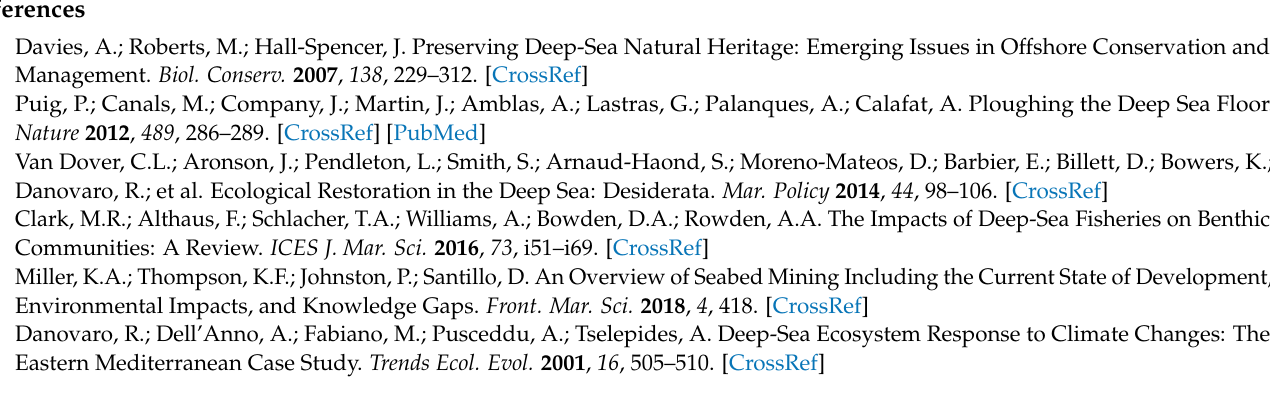
Table S2: Annotated morphopecies belonging to each cluster after hierarchal cluster analysis of 288 sample images. Mean density (m 2 ) of each morphospecies within each cluster, total annotated and percent occurrence across images is provided for each